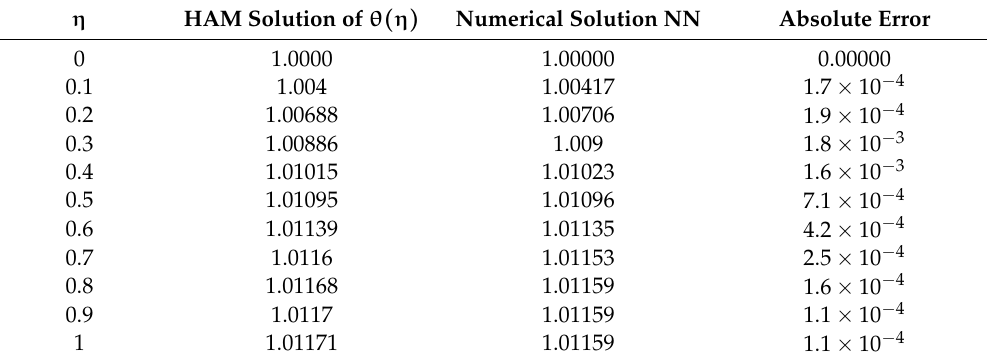
Table 2. Comparison between HAM and numerical solutions are shown for temperature field θ ( η ) when (cid:125) = − 0.45, P r = 10, B r = 0.1, N r = 0.1, D u = 0.1, S c = 0.1, ε = 0.1, S r = 0.1, λ = 0.1, Λ = 0.1, β = 1, S = 0.1.